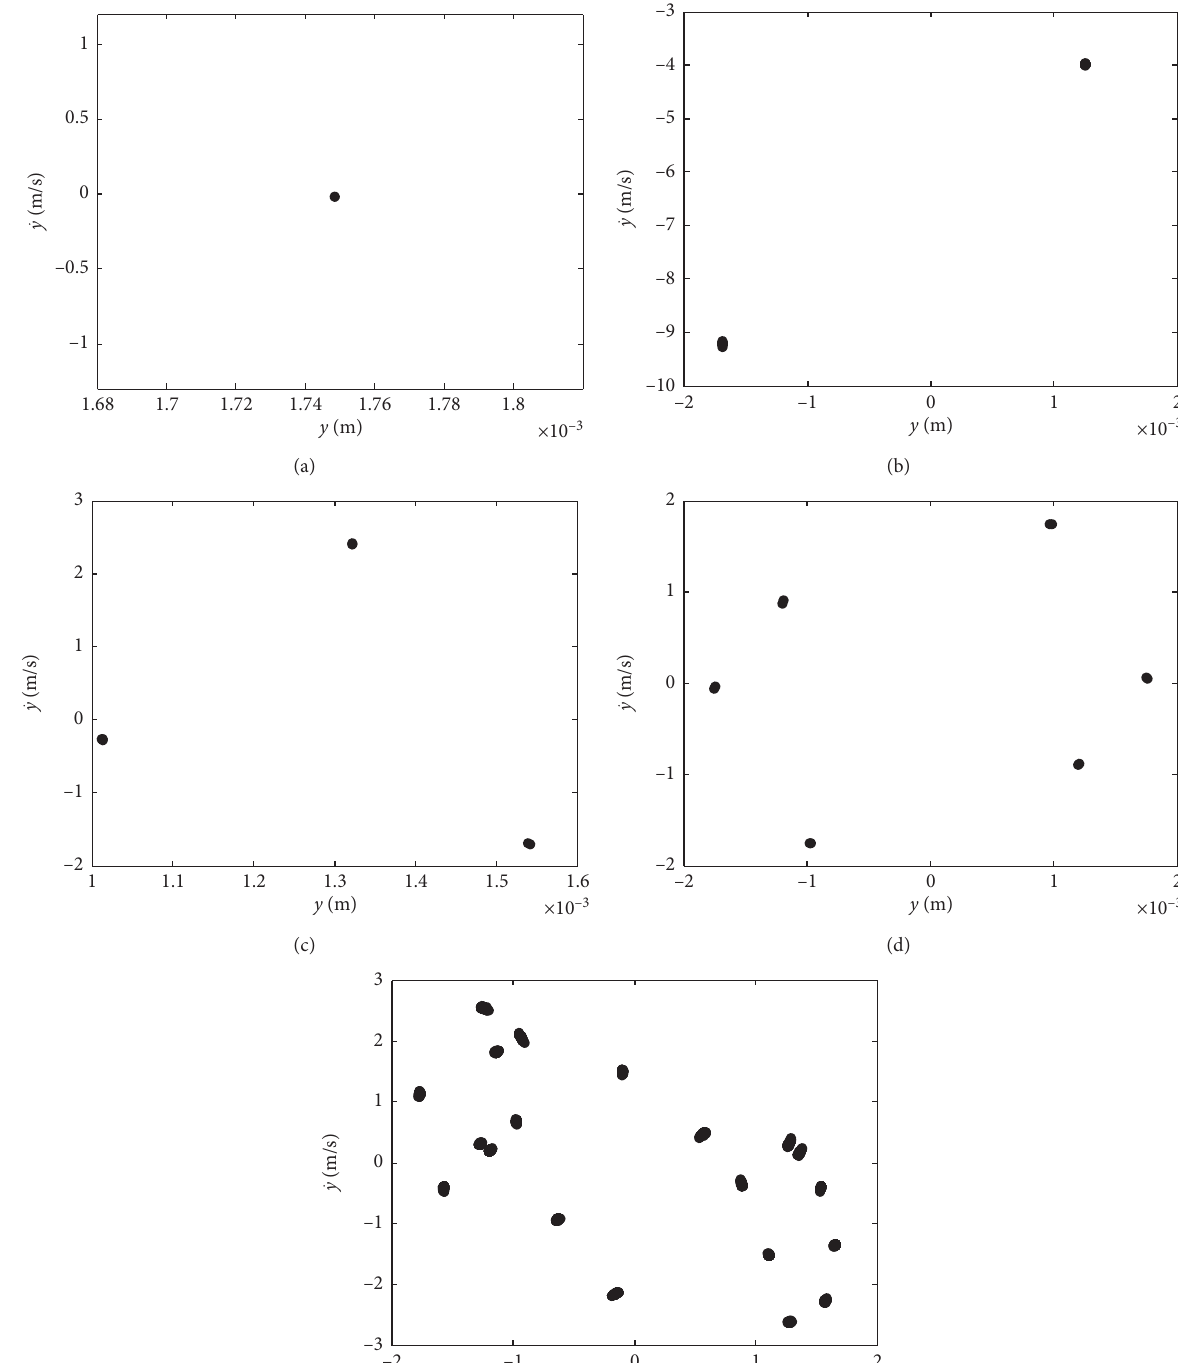
Figure 12: Poincare section of vertical vibration under varying external excitation amplitude: (a) F (c) F 0 � 5.90 e N, (d) F 0 � 6.05 e 5N, and (e) F 0 � 6.55 e motion, period-doubling motion, and chaotic motion in the horizontal direction, and the movement alternates among these forms. Thus, different forms of chatter marks are caused on the steel strip.